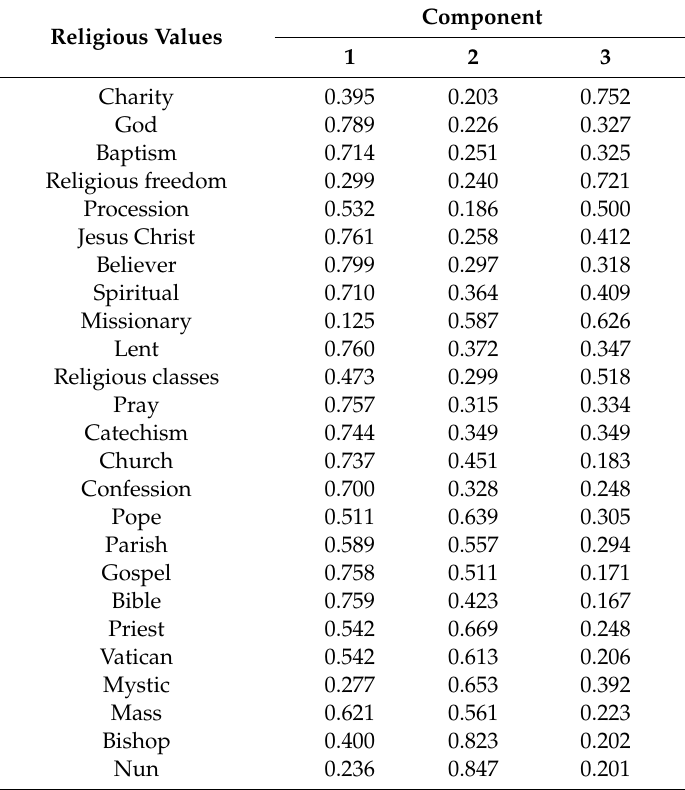
Table 11. Matrix of rotated components